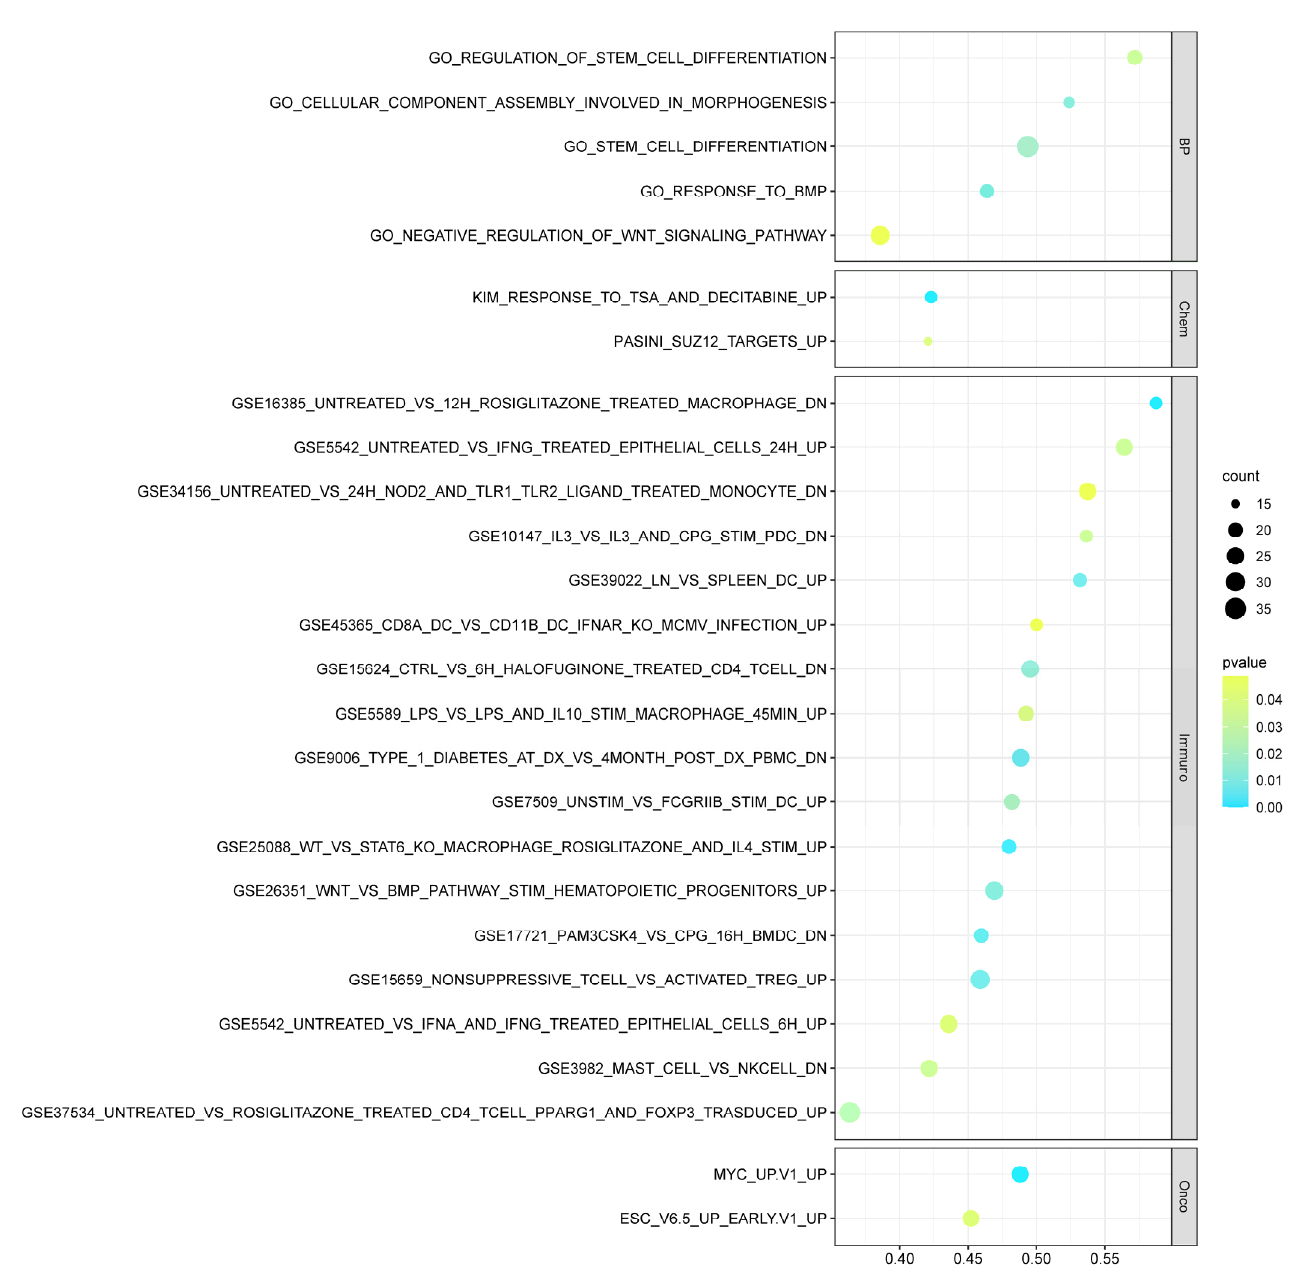
Figure 6. GSEA analysis of HER2+ and HER2 − breast cancer and CRC patients revealed significant enrichment of common pathways. The figure shows the 26 significant pathways among CRC and BC in HER2+ vs. HER2 − patients. Immuno , Immunologic Signature; Onco , Oncogenic Signature; BP GO , Biological Process; Chem , Chemical and Genetic Perturbations.